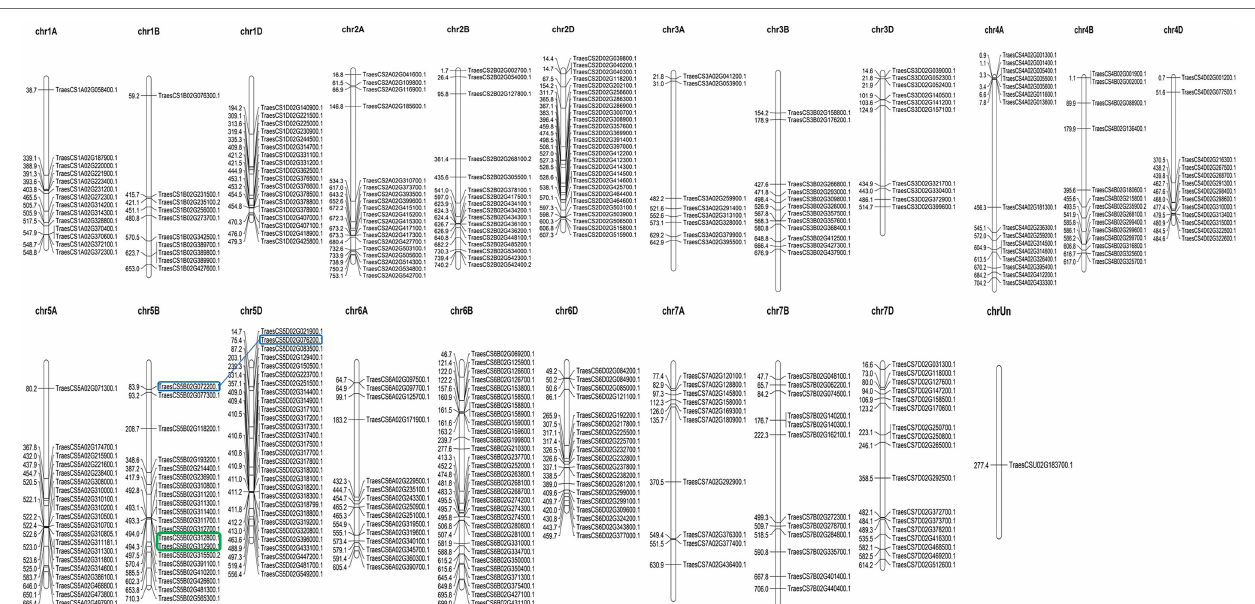
FIGURE 4 | Distribution of 351 TaAP2/ERF TF genes in 21 wheat chromosomes and one unknown location generated in MapChart software. The relative positions of the genes on each chromosome are displayed at the top of each chromosome. The number of TaAP2/ERF TF genes per chromosome ranged from 30 in chromosome 6B to 1 as on the unknown position. Among the 128 pairs of segmental duplicates detected in TaAP2/ERF family TF genes, the one pair tandem duplicate is marked with a green box and one pair of segmental duplicated genes with the highest sequence similarity and identity of 99.18% is marked with blue boxes connected with a blue line. Gene duplication analysis was done based on the similarity and identity matrix of the full-length protein sequence generated from the Sequence Identity and Similarity (SIAS) online